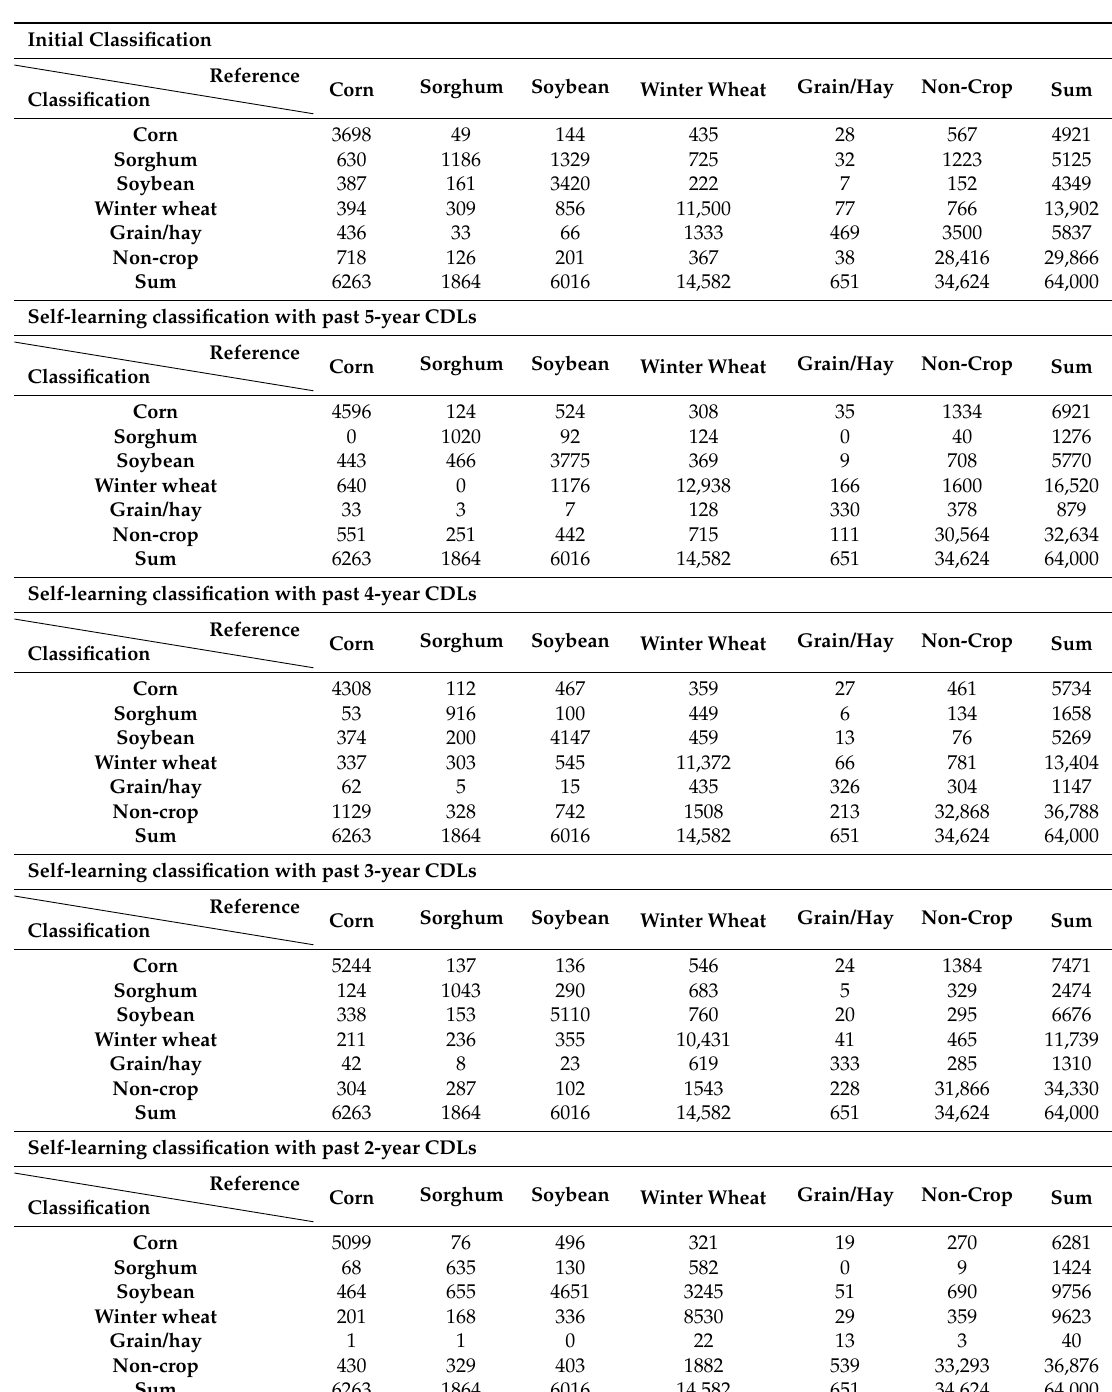
Table 5. Confusion matrices for initial classification and self-learning classification for four different CDL combination